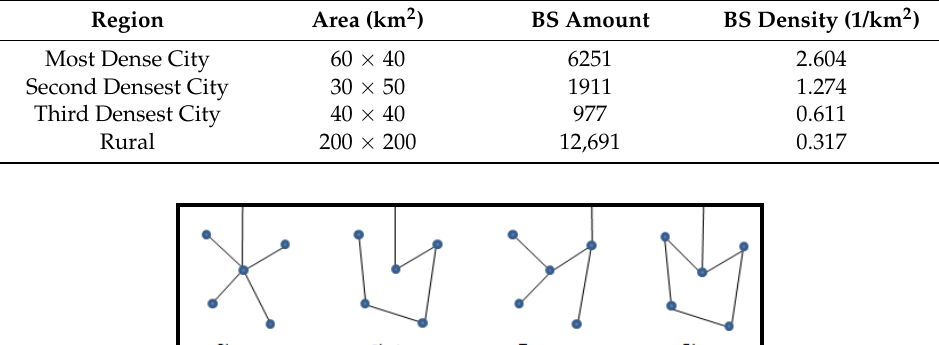
Table 1. Statistical base station (BS) densities [10]. BS densities depend on population densities. Since cellular microwave-links (CMLs) topologies are such that the number of CMLs is nearly identical to the number of BS, this table also reflects spatial densities of CMLs.